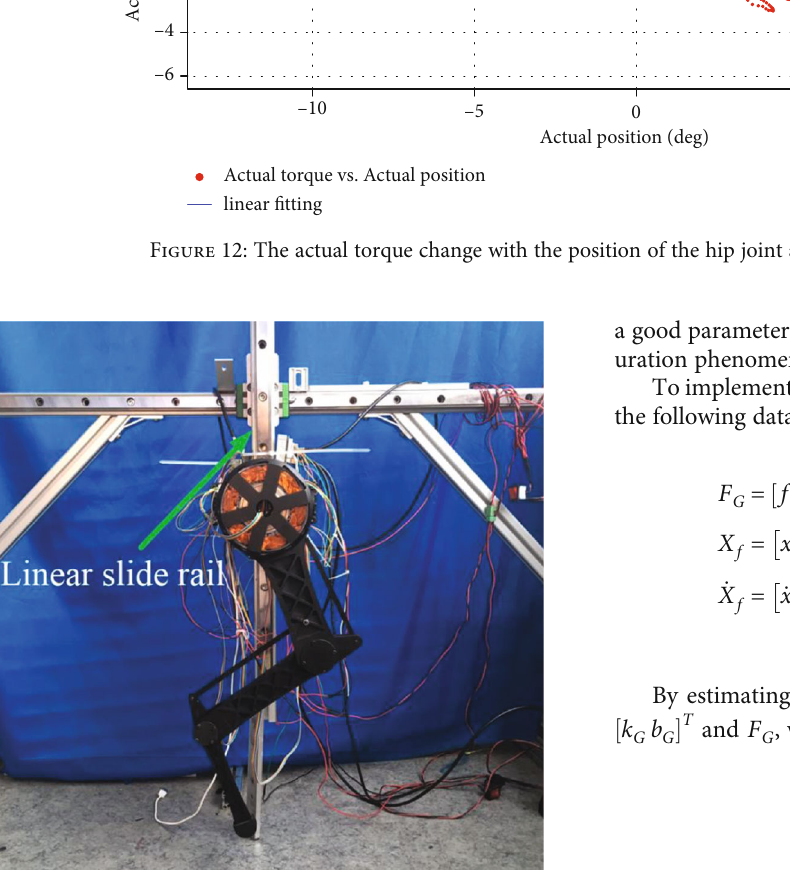
Figure 13: Diagram of free dropping apparatus of the single-leg